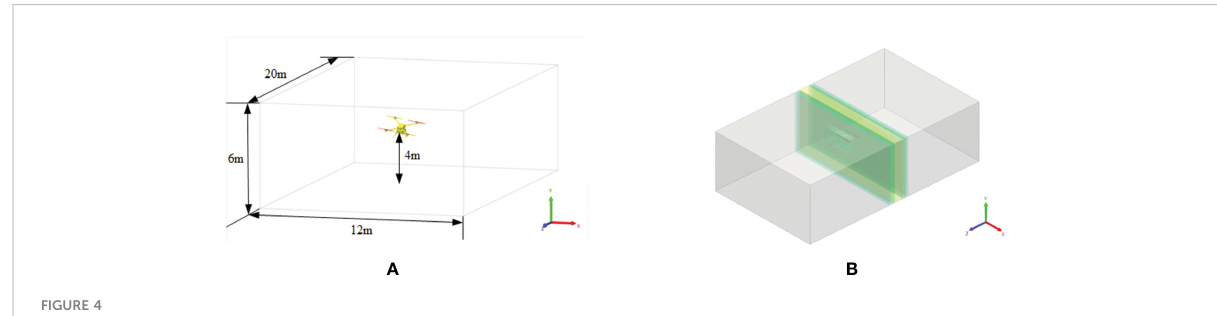
FIGURE 4 Fluid calculation domain and Discrete division of the computational domain.